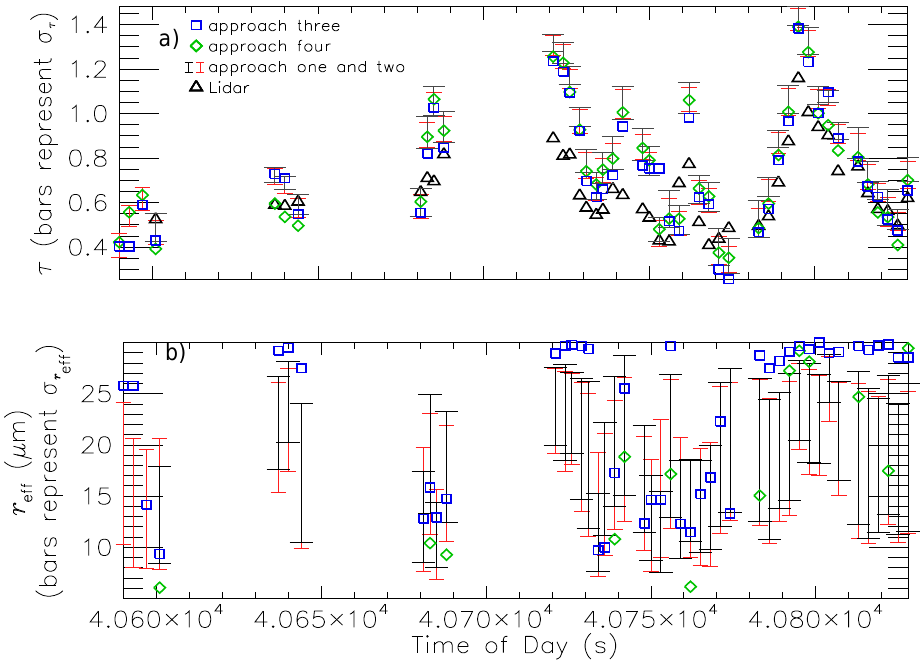
Fig. 12. (a) Comparison between σ τ of retrieval approach using approach 1 (red bars), approach 2 (black bars), τ of standard retrieval using approach 3 (blue squares), τ of retrieval using approach 4 (green diamonds) derived from HALO-SR measurements, and τ derived from the HSRL (triangles) for the 4 November 2010 flight. Gaps are caused by roll movements of the plane, where nadir measurements could not be obtained. (b) σ r and r eff of the corresponding time. Time is given in UTC. reff